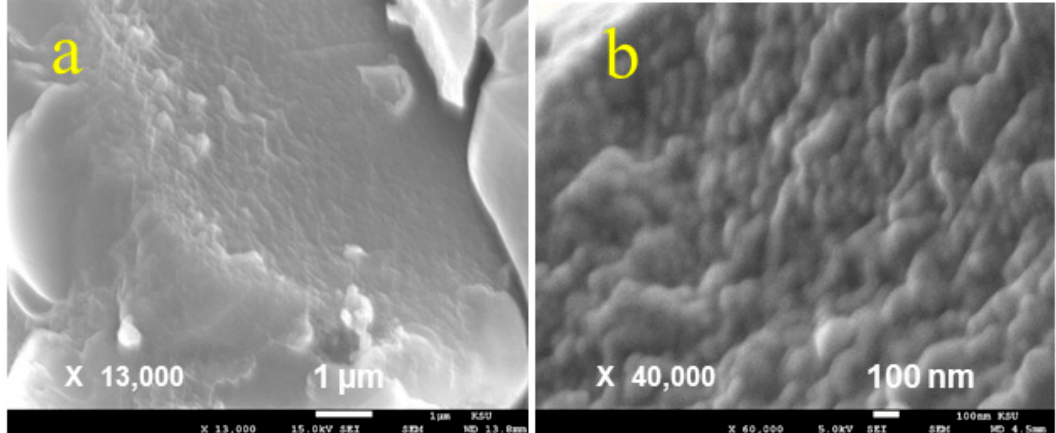
Figure 5. ( a , b ) FE-SEM micrographs of CAPUOA/FS2surface at different magnification reveals the homogenous distribution of fumed silica in the matrix.